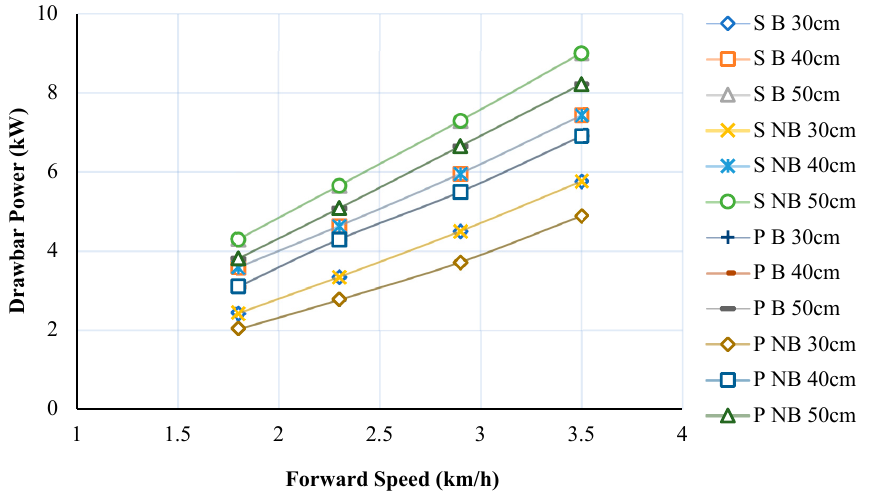
Figure 4. The relationship between speed, depth, vertical load and drawbar power at studied tines (S—Subsoiler; P—Paraplow; B—225 kg vertical load; NB—No load).